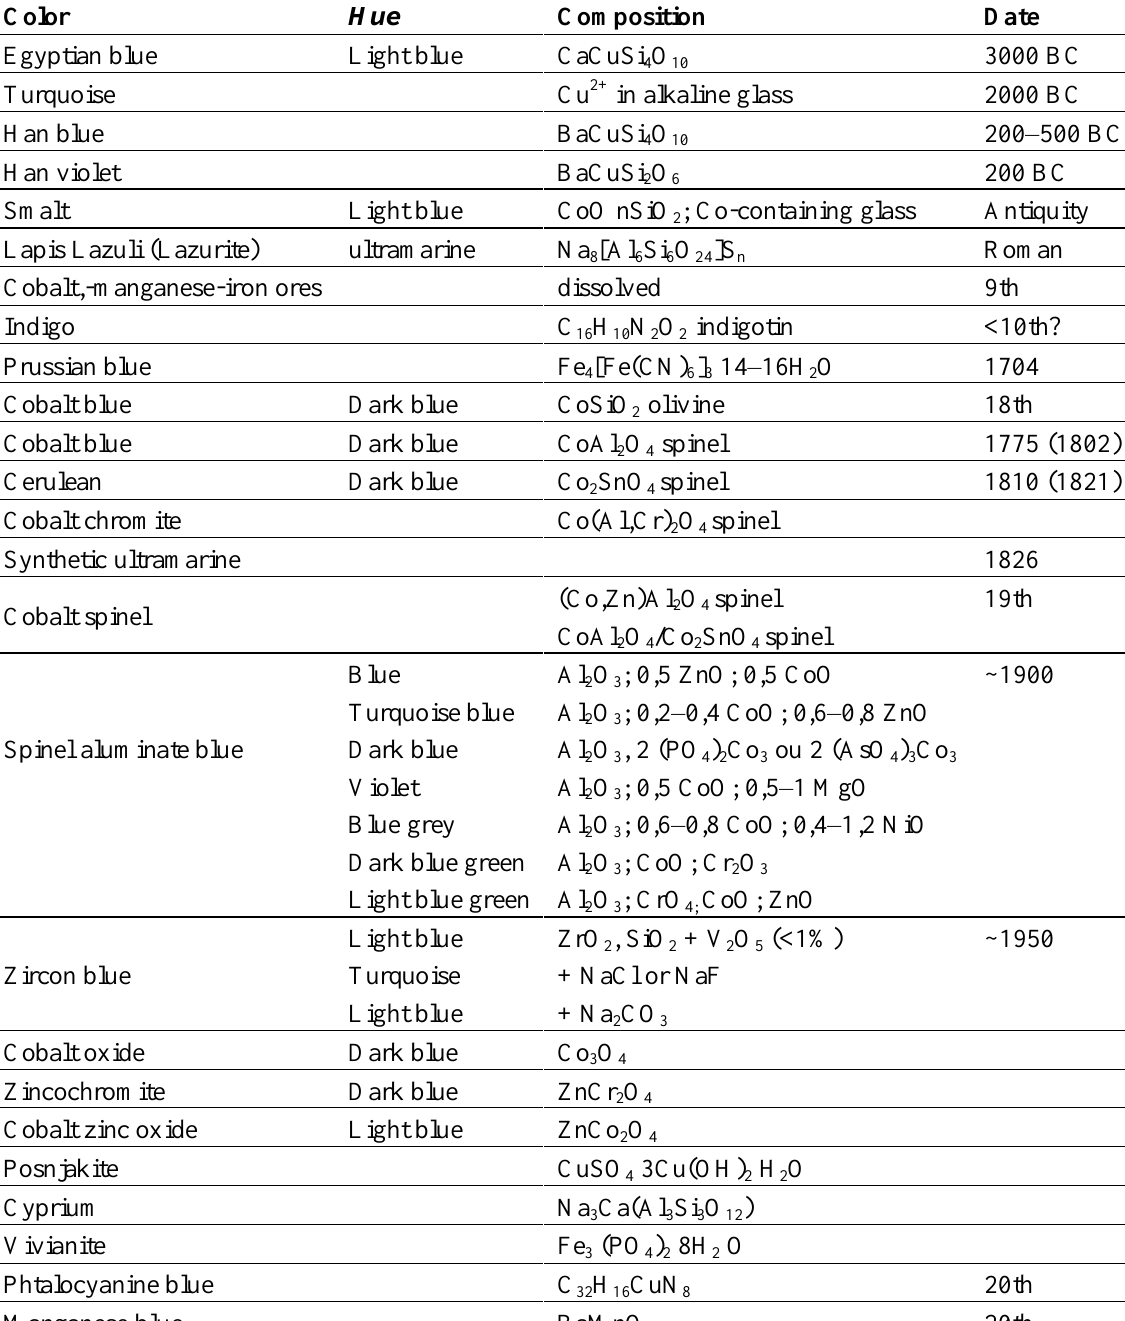
Table 2. Name and composition of blue pigments and coloring agents. Dates of innovation (first production) are